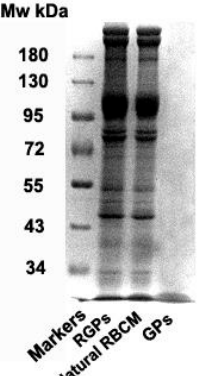
Figure 5. Protein detection in RGPs, natural RBCM, and GPs by SDS-PAGE stained with Coomassie Brilliant Blue and photographed under the Tanon2500 Gel Imaging Analysis System.